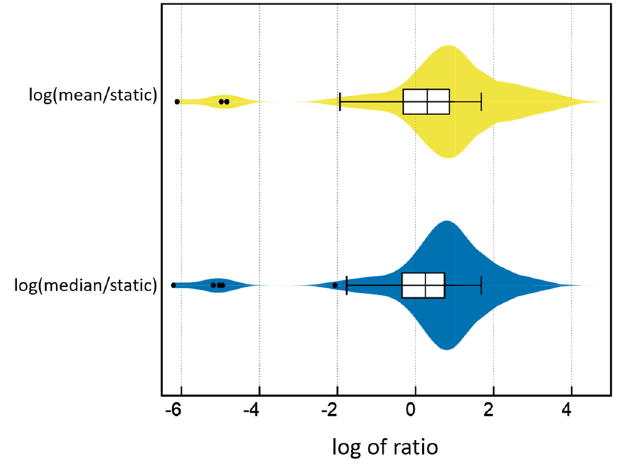
Fig. 7 Distribution of the ratios of stochastic to static values of all midpoint indicator results. These include the results of all case studies, respectively for construction and operation. The ratios are presented on a log-scale, meaning that the value is 0, if static and stochastic values (mean or median) are equal. Boxplots display the statistical analysis of the datasets (25th percentile, median, and 75th percentile), while black points represent